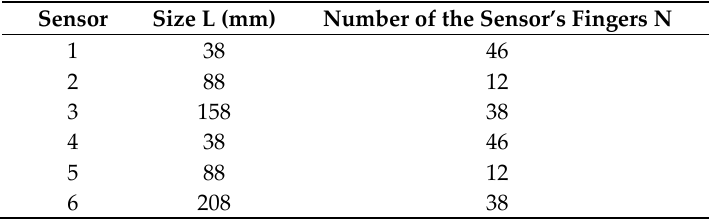
Table 1. Sensor geometry, finger width 2 mm, distance 2 mm, thickness 1 µm.